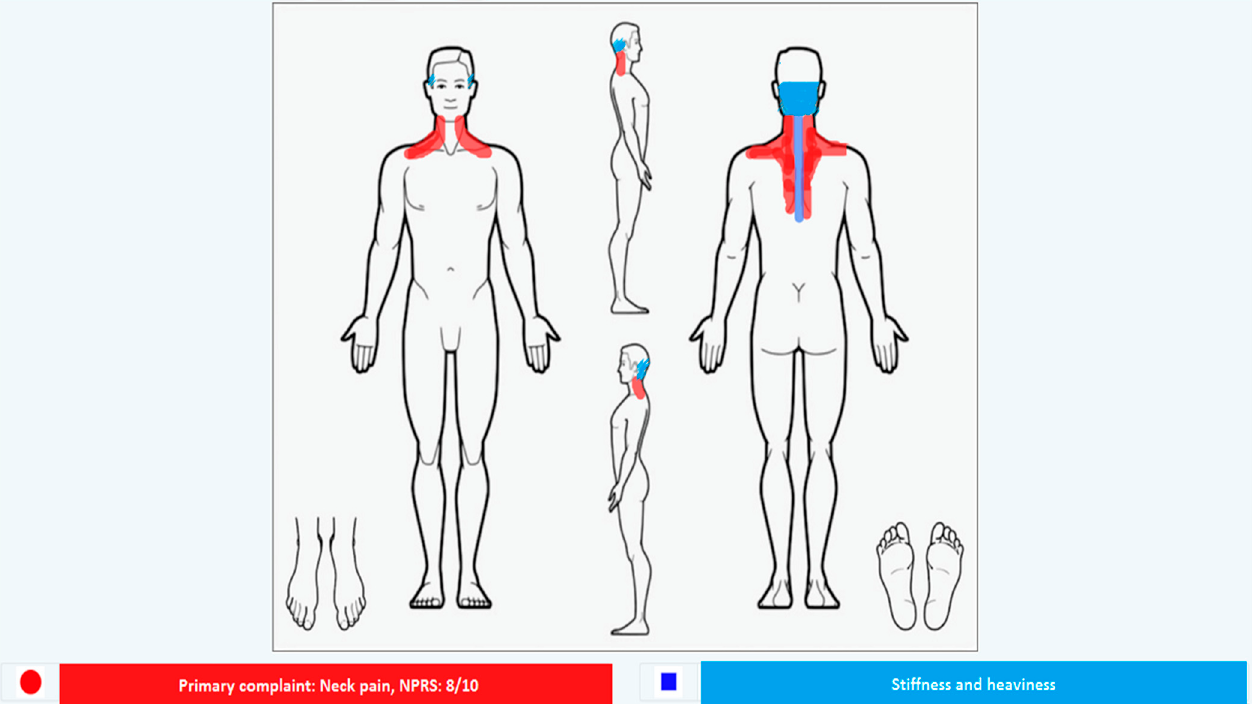
Figure 1. Symptoms at first assessment. In red: NP NPRS 8/10 during working and training activities; in blue: neck sti ff ness NPRS 7/10 and feeling of heaviness in the head.